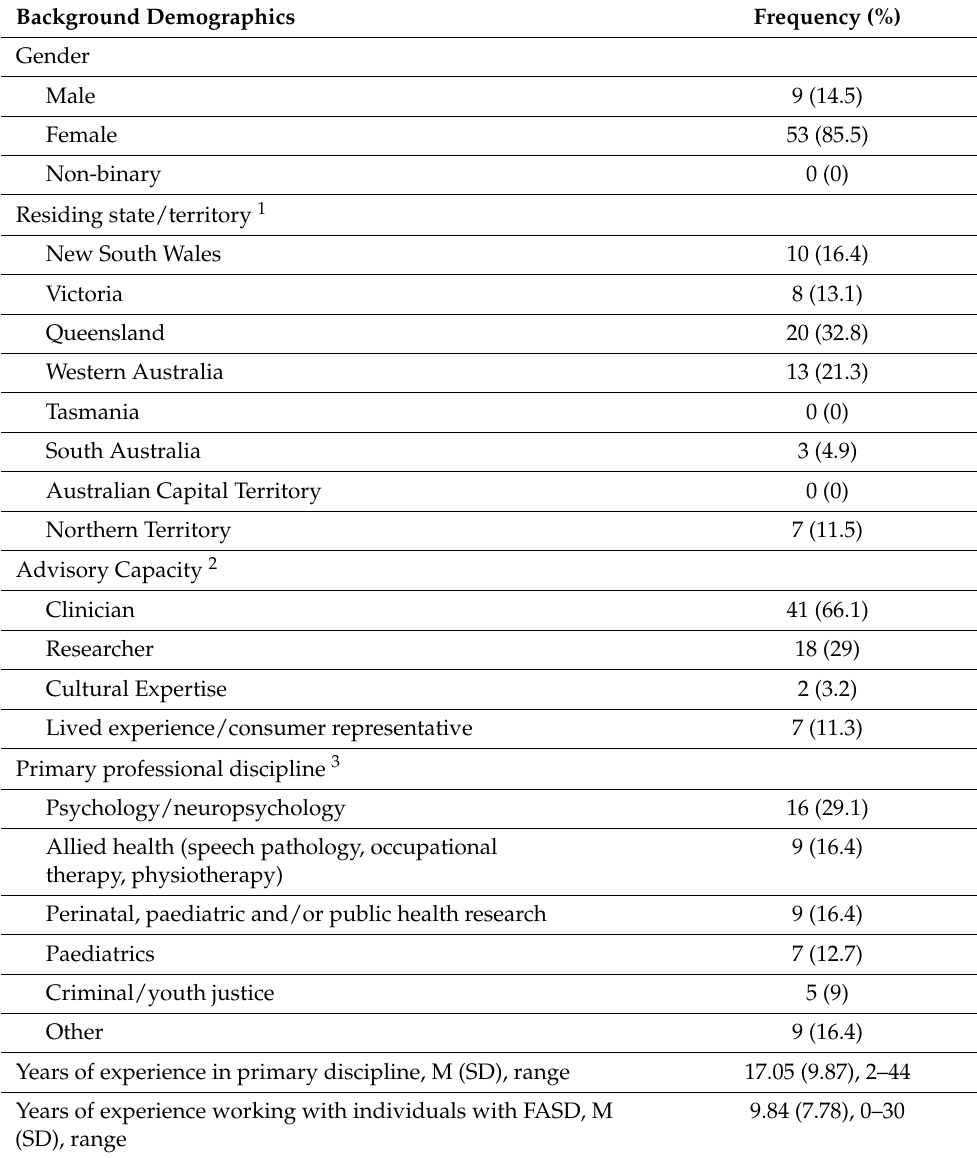
Table 2. Key stakeholder background demographics ( n =